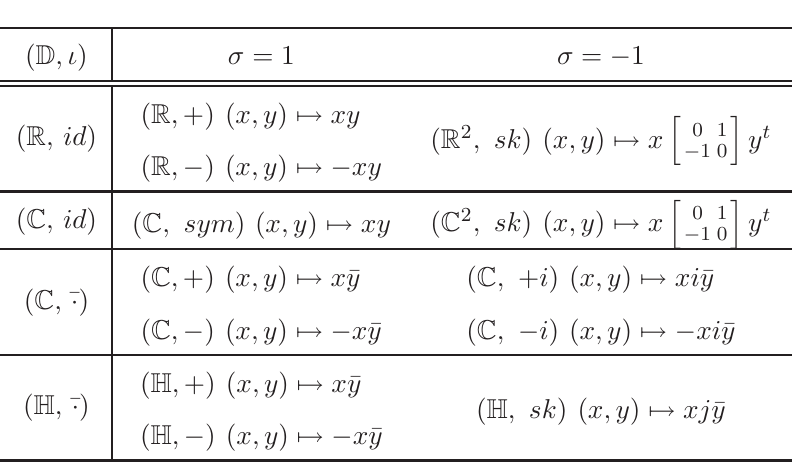
Table 1 The list of indecomposable σ -hermitian